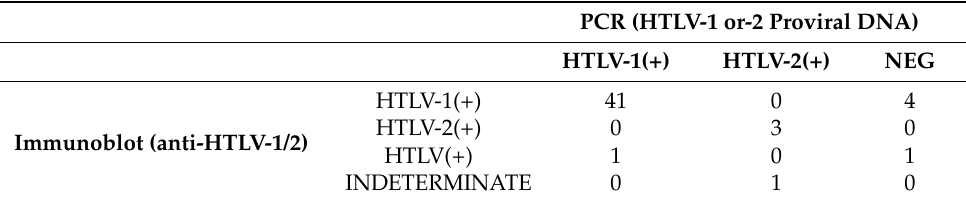
Table 4. HTLV-1/2 supplementary tests results of the 51 positive blood donors.